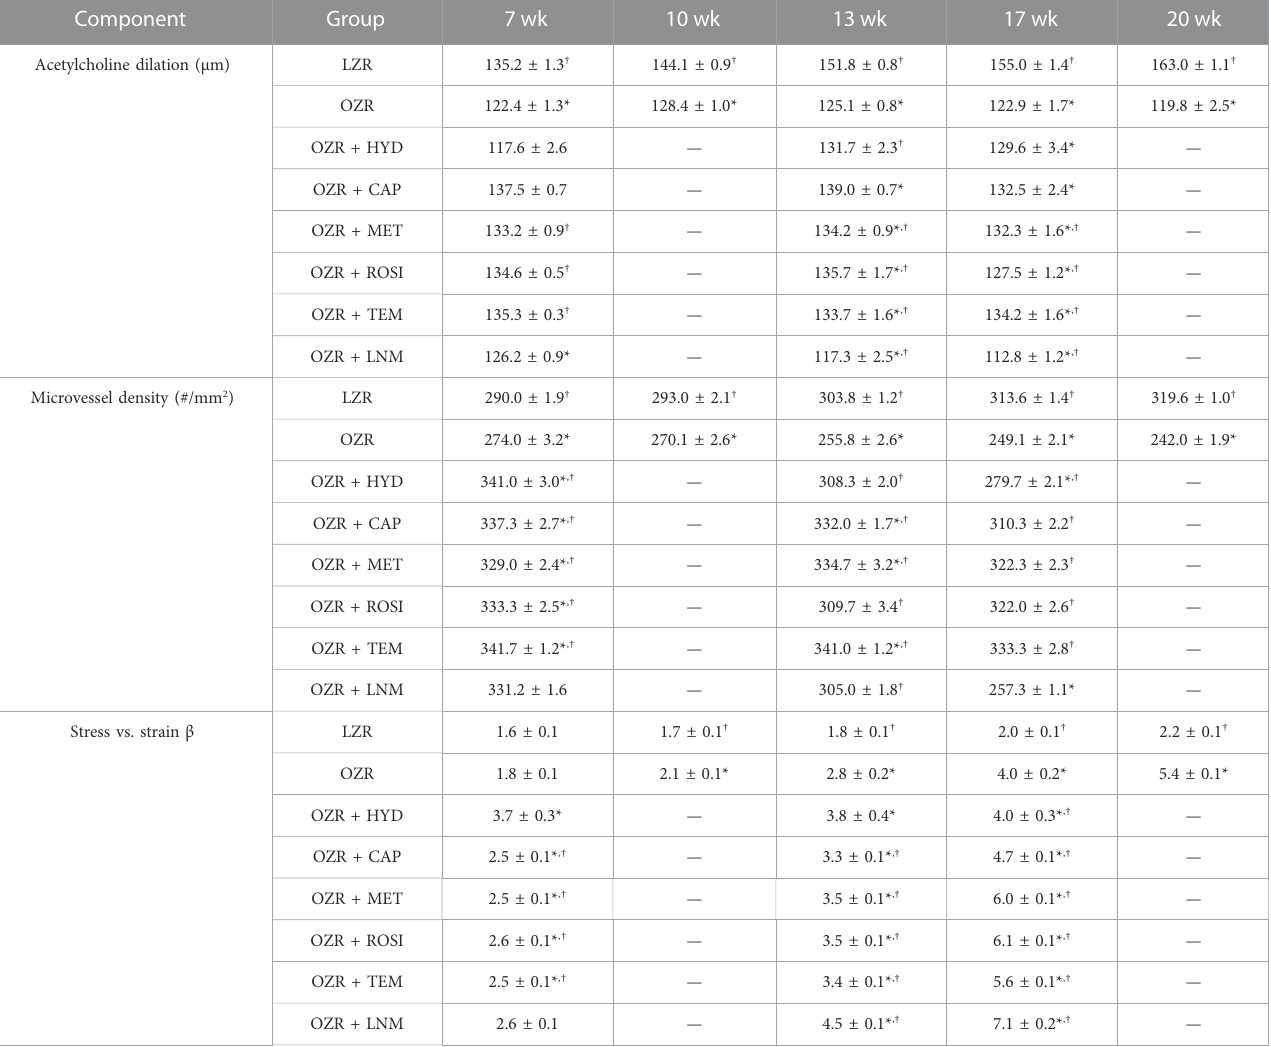
TABLE 5 Cerebral vascular component data, presented as mean ± SE, for the animal groups of the present study across all age.